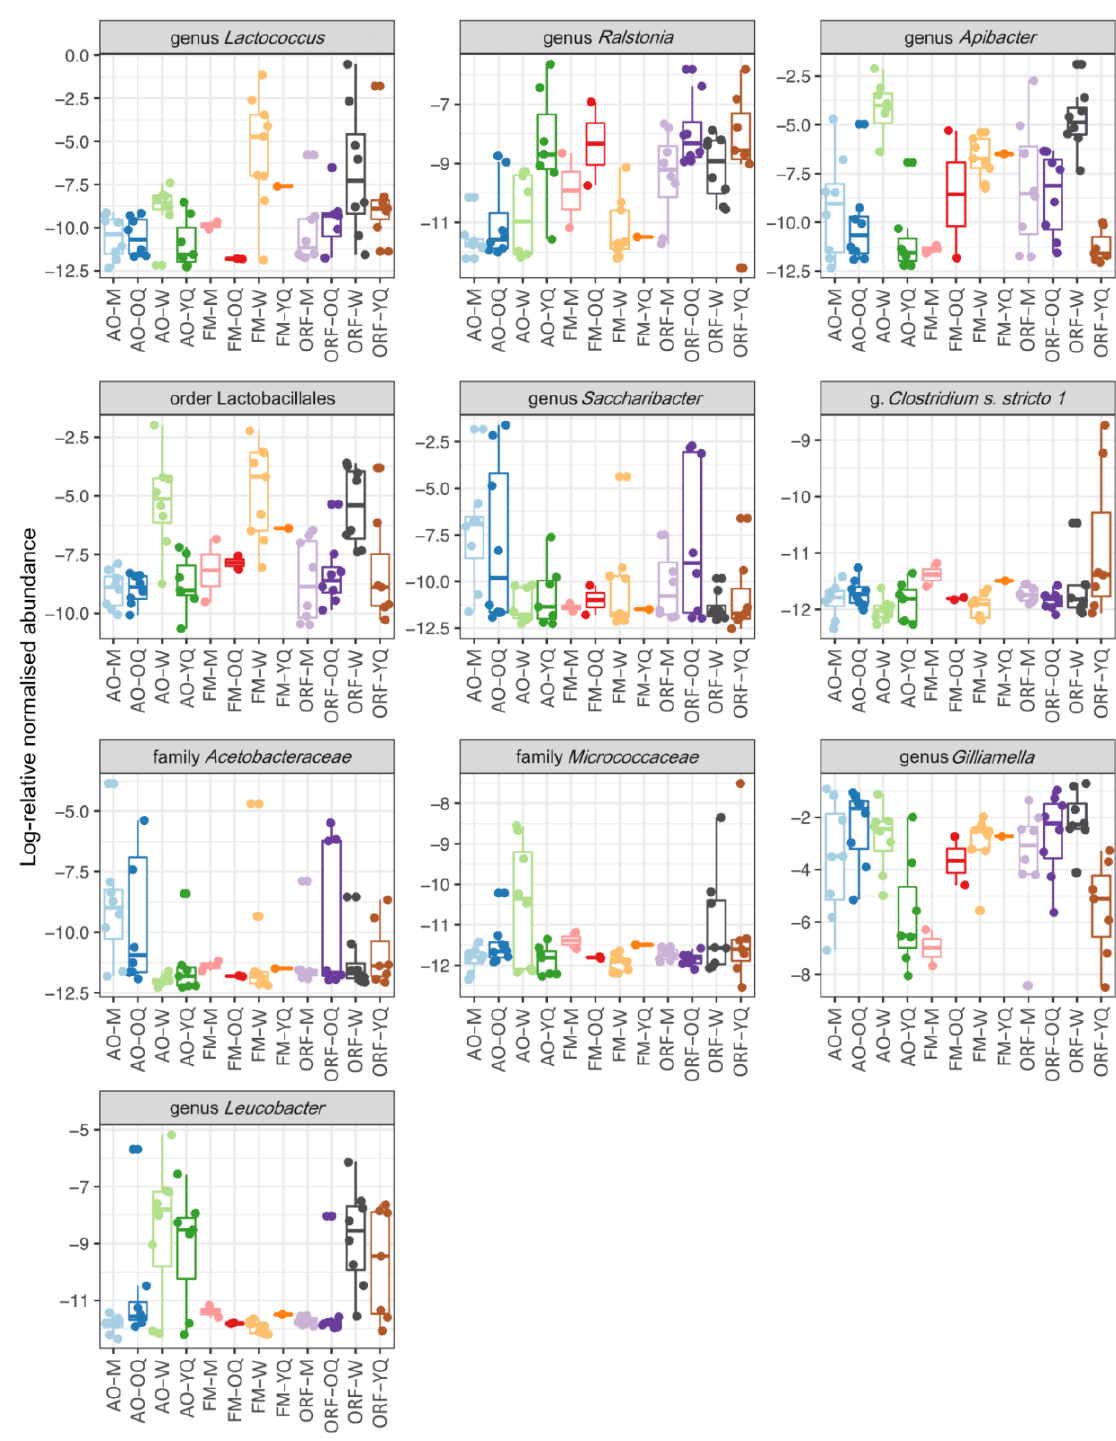
Figure 5. Log-relative abundance of the differentially expressed bacterial genus in the guts of Bombus terrestris collected from apple orchards (AO), forest meadows (FM), and oilseed rape fields (ORF), as well as across males (M), ovipositing queens (OQ), workers (W), and young queens (YQ).